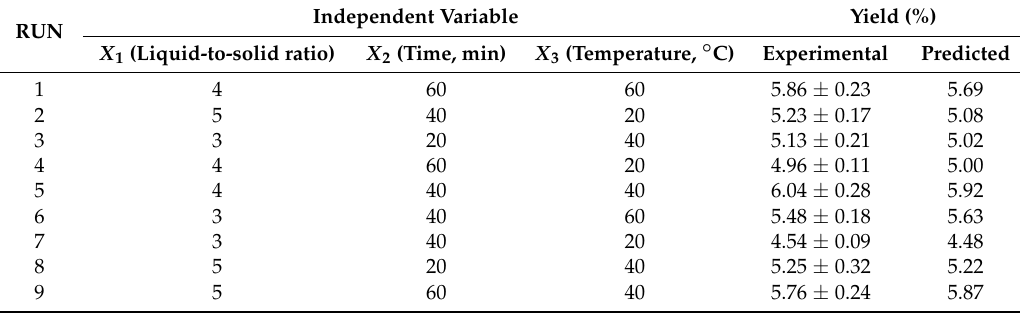
Table 1. Box-Behnken design (BBD) matrix and the response values of the extraction yield of OBO. Independent Variable Yield RUN